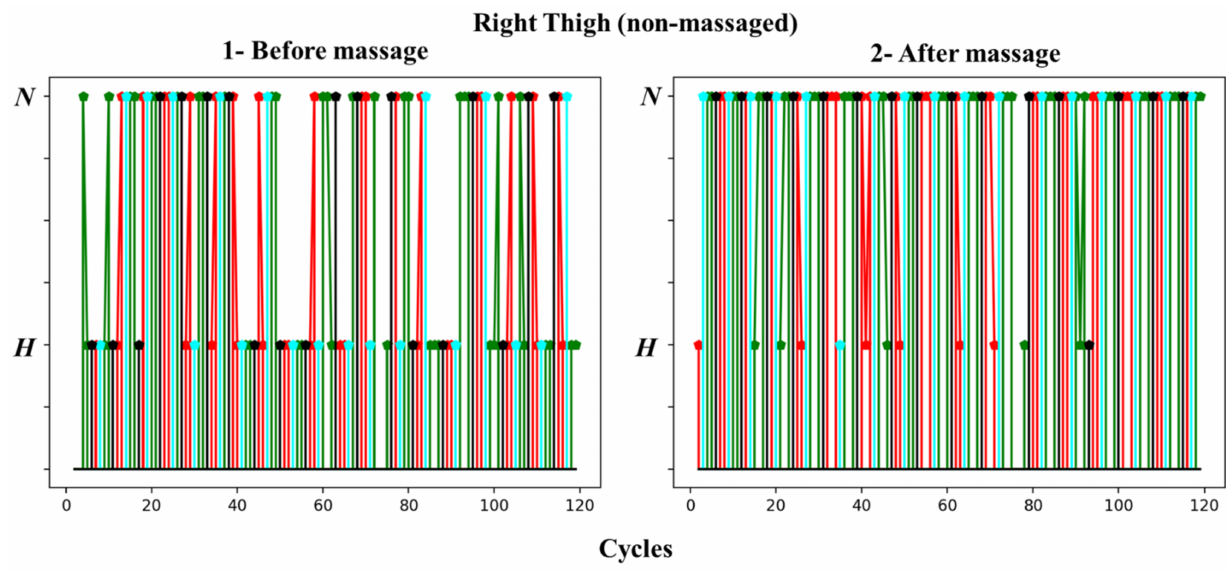
Figure 10. Changes in vascular tone for 120 cardiac cycles in the right thigh (non-massaged) before and after